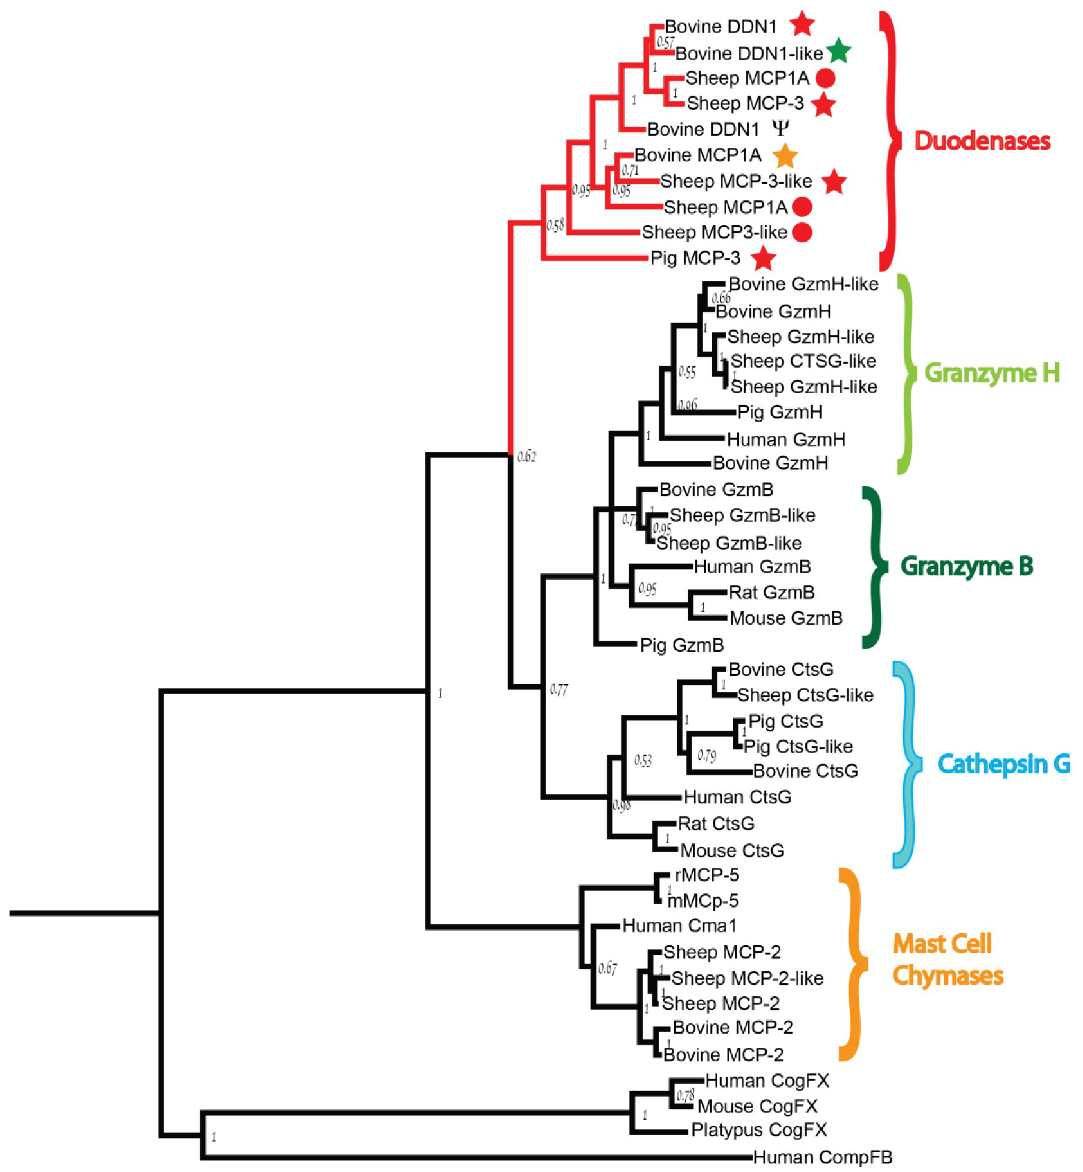
Fig 3. A phylogenetic analysis in the form of a phylogenetic tree of chymase locus genes. A number of mammalian chymase locus genes have been analysed for sequence relatedness using the neighbour joining algorithm. Human complement factor B and a few coagulation factor X proteins were used as outgroup. Duodenases form a clear subfamily distinct from the cathepsin G, granzymes and chymases. The six genes analysed in more detail for their cleavage specificity is marked by stars as in the Fig 2 and the genes not yet characterized are marked with a red dot, also similar to the Fig